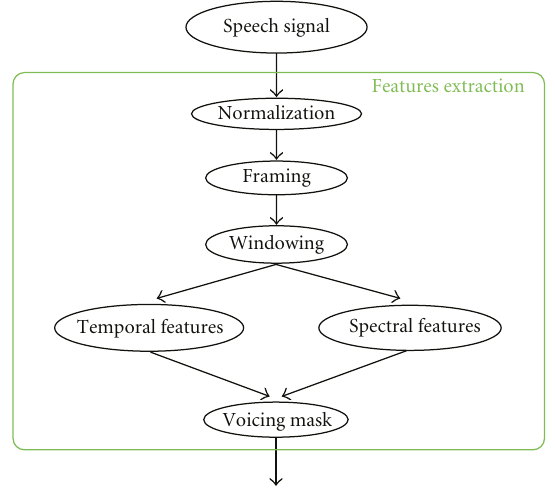
Figure 2: Details of the first part of the analysis